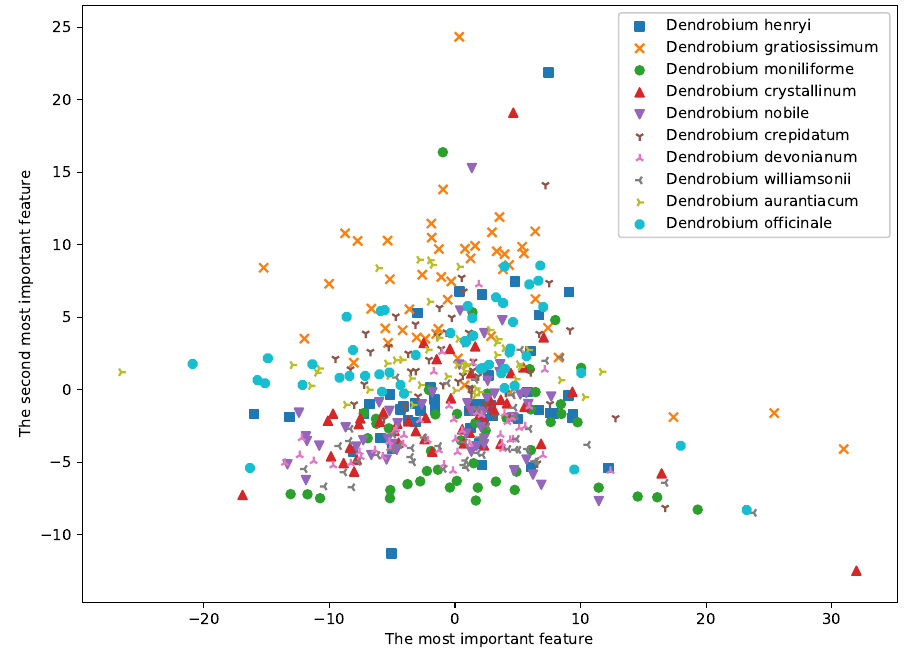
Figure 4. Distribution of samples using PCA method.